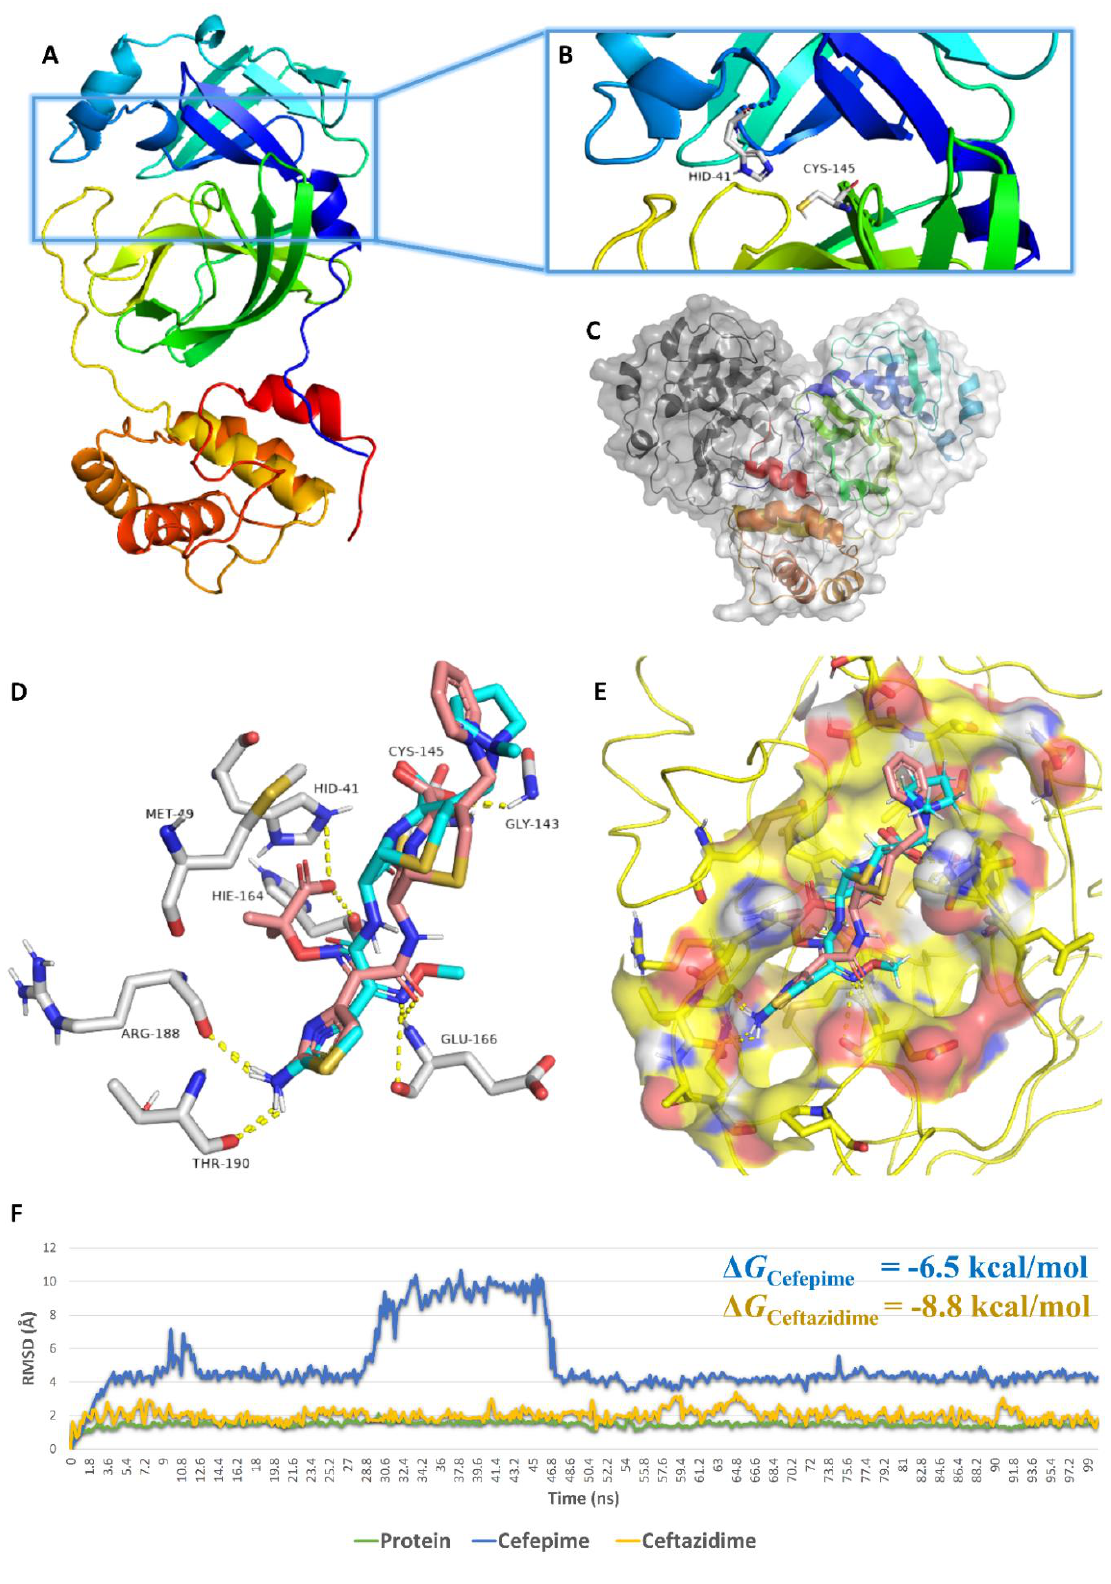
Figure 3. Structure of SARS CoV- 2′ M Pro showing its active catalytic site ( A , B ) and its dimeric active form ( C ). Binding mode of both ceftazidime and cefepime inside the M Pro active site ( D , E ; ceftazidime was colored in brick-red and cyan colors, respectively). RMSDs of both ceftazidime and cefepime inside the M Pro active site during the course of 100 ns fo MDS ( F ).